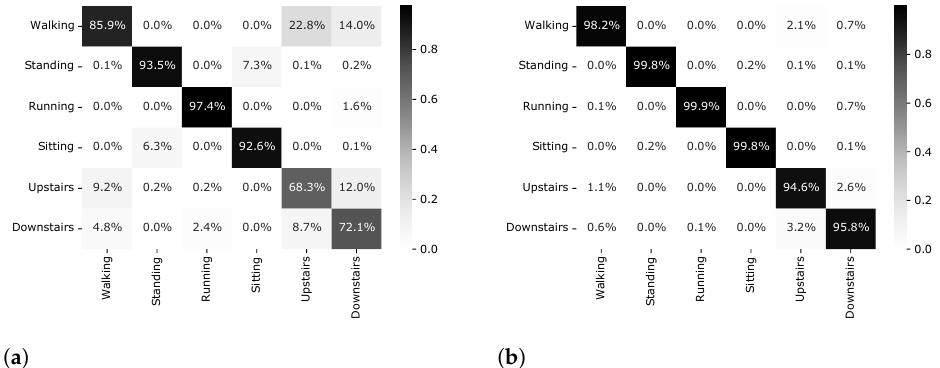
Figure 6. Confusion matrix of Random Forest algorithm results for universal model and personal model using the SHOAIB dataset. ( a ) Universal model. ( b ) Personalized